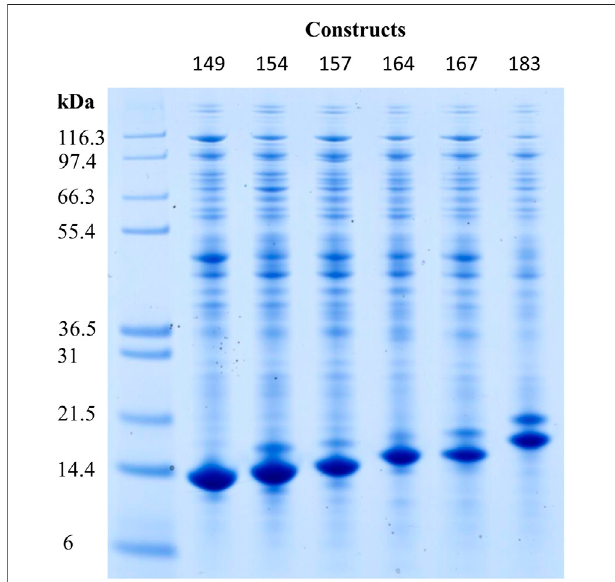
FIGURE 2 | Reducing SDS-PAGE scan of HBcAg VLP construct monomers after re-dissolution in lanes two to seven, with Invitrogen Mark 12 Unstained Standard in lane 1. Molecular weights of the proteins in the standard are displayed on the left. Protein staining by Coomassie blue; HBcAg, hepatitis B core antigen; VLP, virus-like particle.